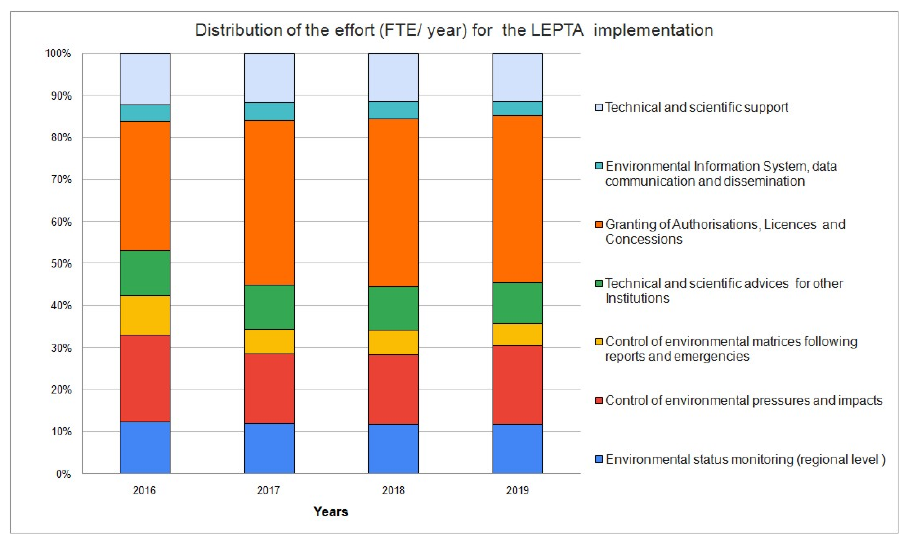
Figure 2. Distribution of the effort for LEPTA implementation in Emilia-Romagna.